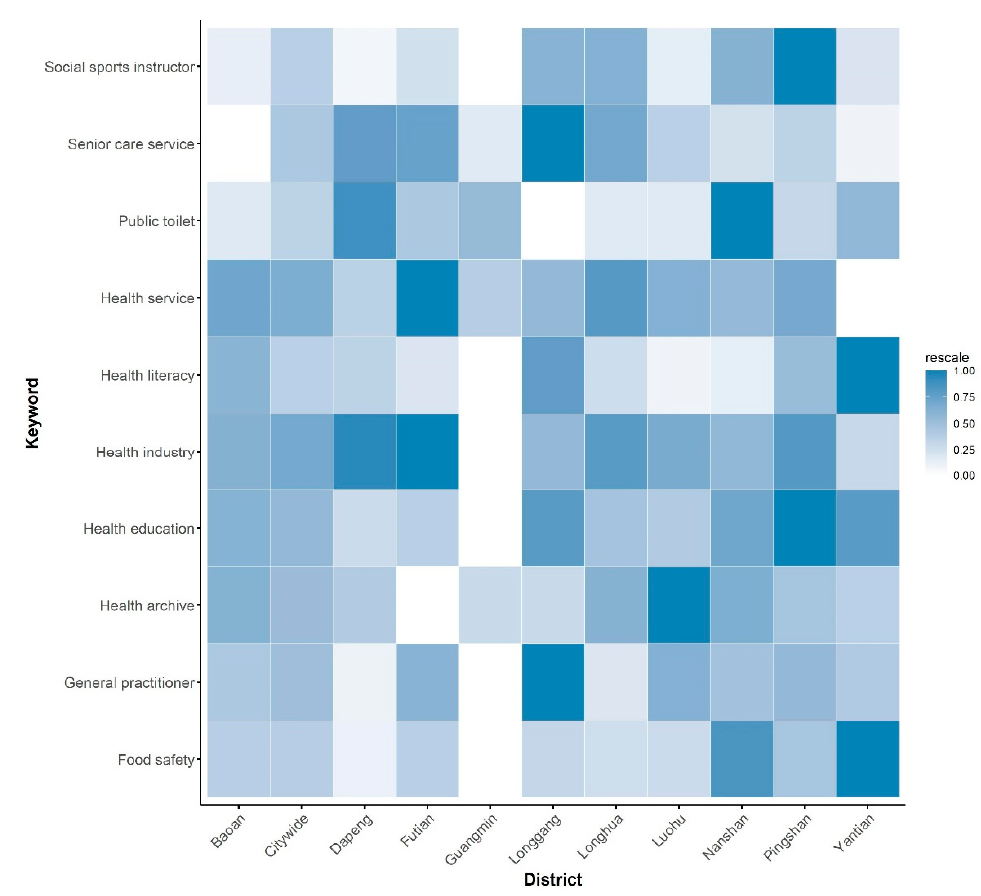
Figure 2. The patterns of the search queries in each district of the top ten keywords queried at the city level. The values were rescaled to 0–1 for comparison.